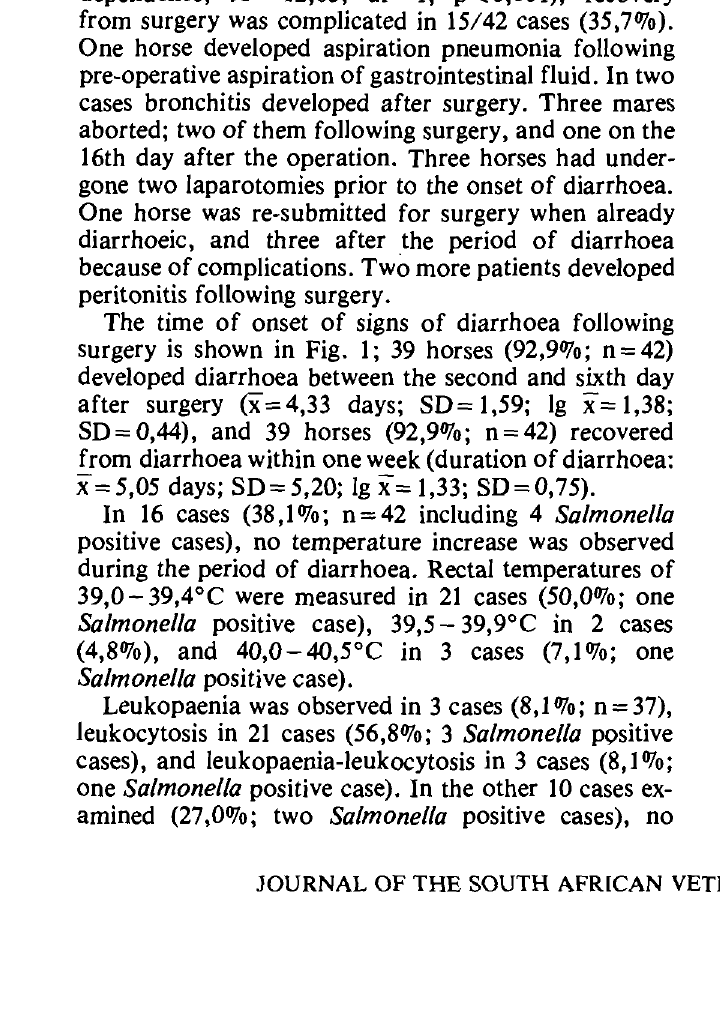
Table 2: Antimicrobials ,in the treatment of acute post· operative diarrhoea